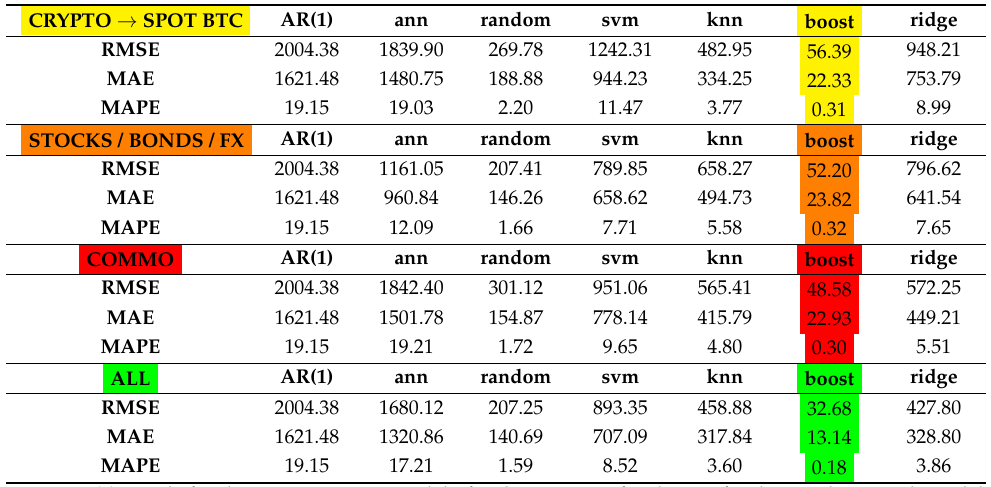
Table 10. Sub-sample forecasting results of Coinbase Bitcoin Spot price during the year 2019. CRYPTO → SPOT